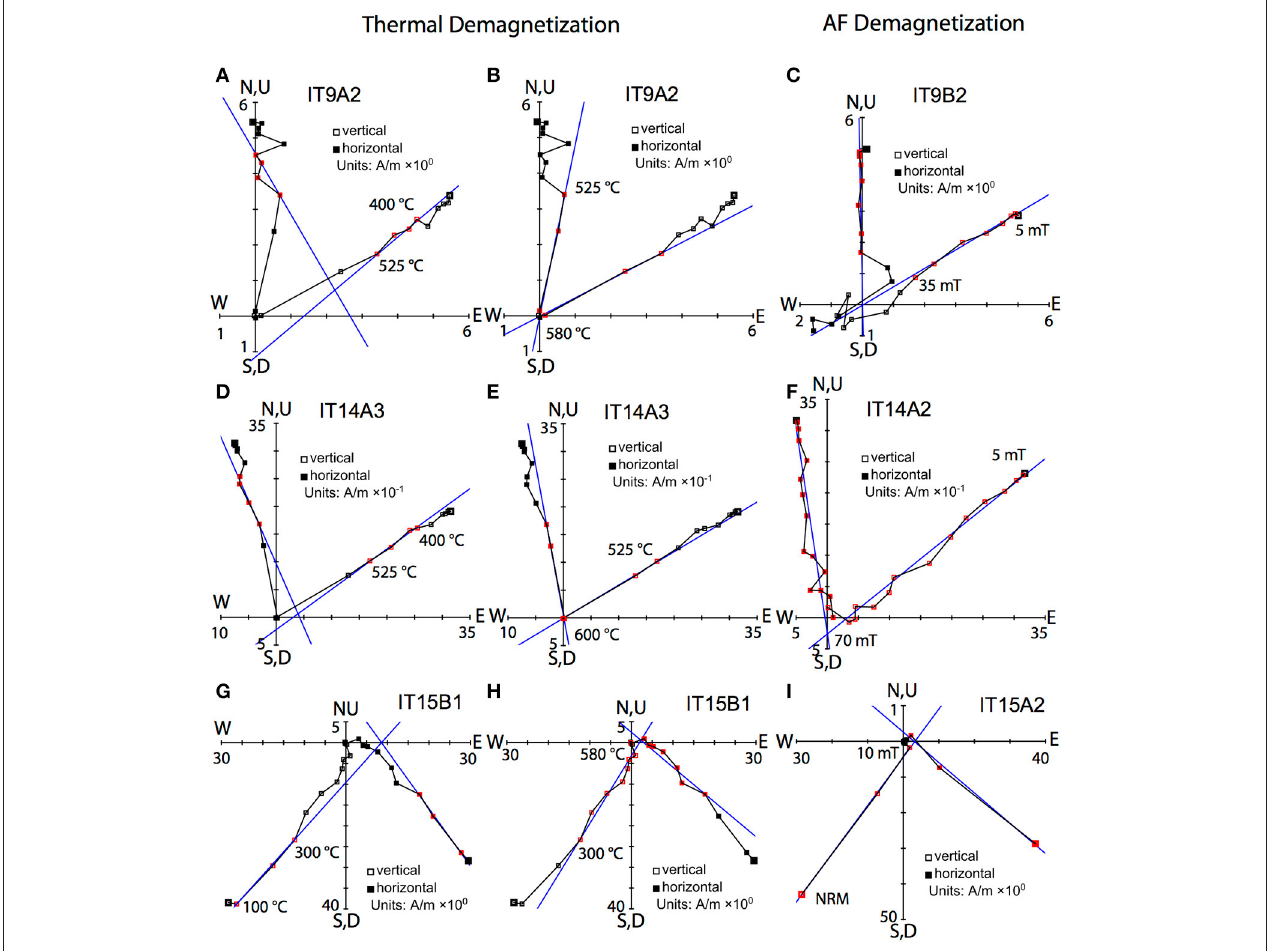
FIGURE 2 | Zijderveld diagrams for selected specimens from the mafic sills: (A,D,G) intermediate temperature component of magnetization, typically isolated between 400 and 525 ◦ C; (B,E,H) high temperature component isolated in the same specimens as in (A,D,G) typically between 525 and 600 ◦ C; (C,F,I) AF demagnetization revealing one component of magnetization only. See text for